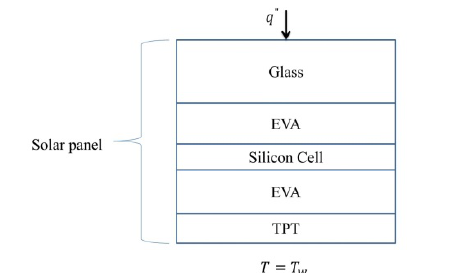
Figure 1. boundary conditions and different layers of solar panel Table 1. properties of different layers of photovoltaic panel (Liu et al., 2017)